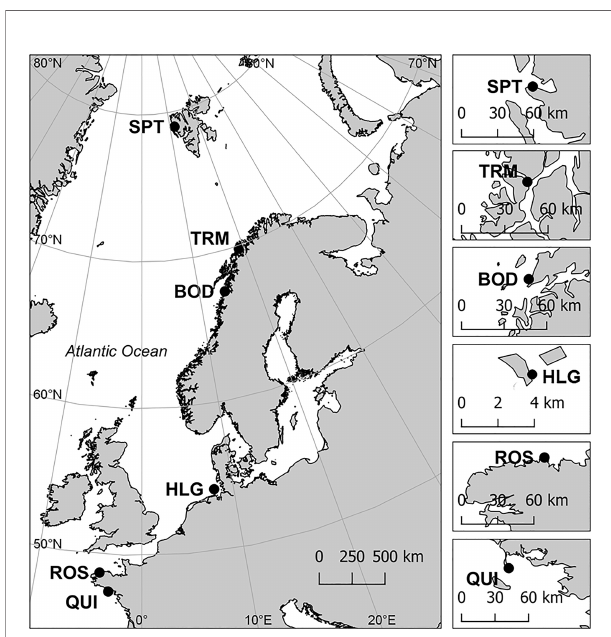
FIGURE 1 | Sampling sites along the NE Atlantic coast. Inset maps show more precise locations within each area. Sampling sites were Spitsbergen, Norway (SPT), Tromsø, Norway (TRM), Bodø, Norway (BOD), Helgoland, Germany (HLG), Roscoff, France (ROS) and Quiberon, France